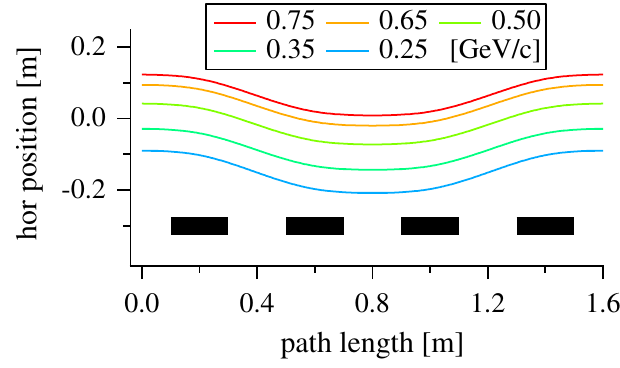
FIG. 3. (Color) Different momentum orbits in a unit cell which satisfies the periodic boundary condition. Rectangles at the bottom show the position of FDDF magnets.